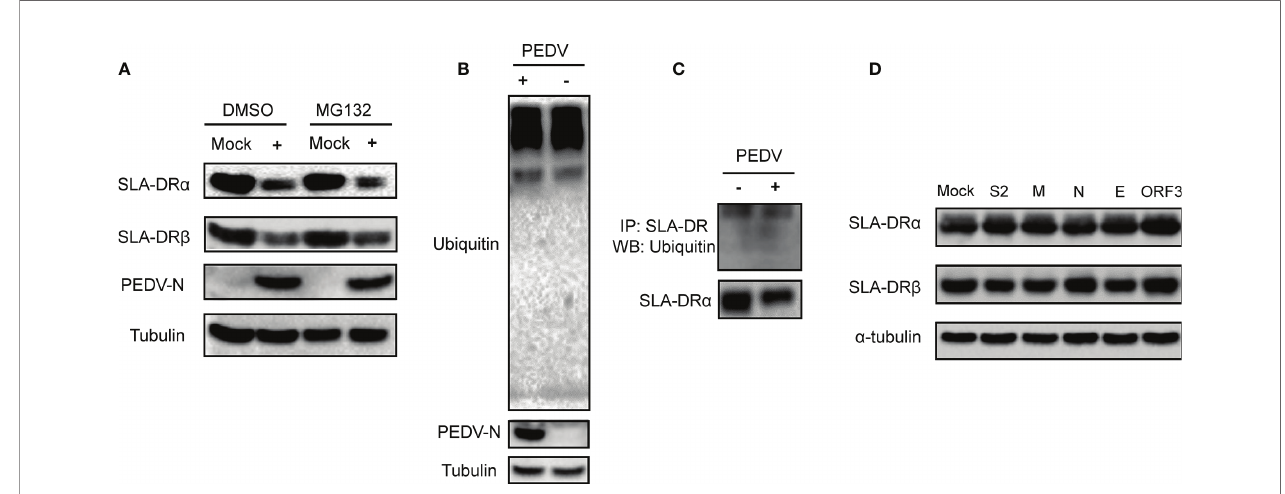
FIGURE 8 | Ubiquitin-proteasome pathway did not involve in inhibition of SLA-DR expression. (A) BM-DCs were infected by PEDV-KB2013-p120 strain at 1MOI for 24, then followed by treatment of either DMSO or MG132 for another 24 hours. Then cells were harvested for western blot evaluating of SLA-DR a , SLA-DR b and PEDV-N protein. Normal BM-DCs cells without PEDV infection but treated with the same dose of DMSO or MG132 were included as controls. Tubulin was probed from the same sample to normalize the total protein load. (B) BM-DCs were infected by PEDV-KB2013-p120 strain at 1MOI for 24 hours. Next, cells were harvested for western blot evaluating of universal ubiquitination level and PEDV-N protein. Normal BM-DCs cells were included as control. Tubulin was probed from the same sample to normalize the total protein load. (C) BM-DCs were infected by PEDV-KB2013-p120 strain at 1MOI for 24 hours. Next, cells were lyzed using RIPA buffer supplemented with protease inhibitor cocktail and NEM for SLA-DR enrichment using anti-SLA-DR Mab-MY533. Enriched samples were subjected to western blot using ubiquitin antibody and anti-SLA-DR a chain antibody. (D) HEK-293T-SLA-DR a / b stable cells were transfected with plasmids encoding S2, M, N, E and ORF3 for 48 hours. Next, cells were harvested for western blot to evaluate expression of SLA-DR a and b . Cells transfected with empty vector were included as control. Tubulin was probed from the same sample to normalize the total protein